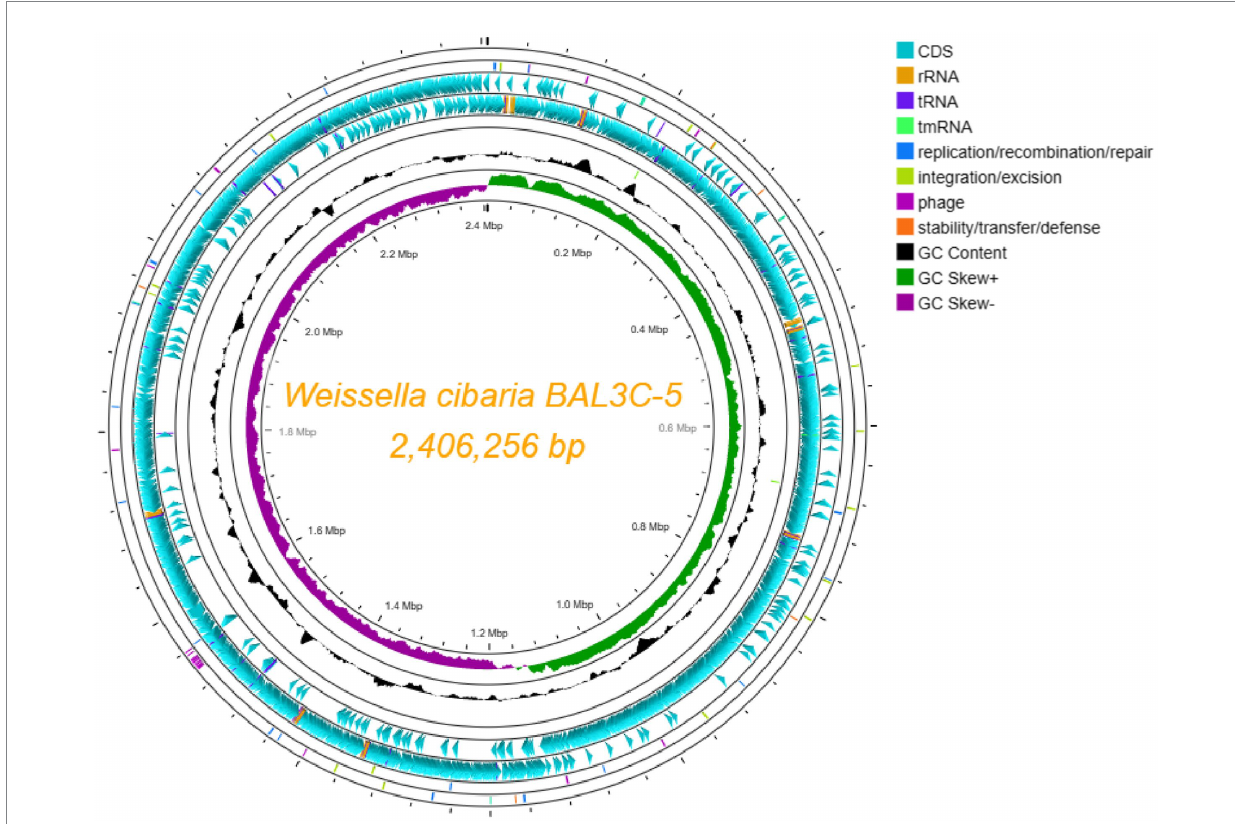
FIGURE 9 Circular genome representation of Weissella cibaria BAL3C-5. Each element color of each circle is shown in the legend. The different rings provide information about: forward CDS, reverse CDS, GC Skew, etc. rRNA, tRNA, and tmRNA are located in the same ring of